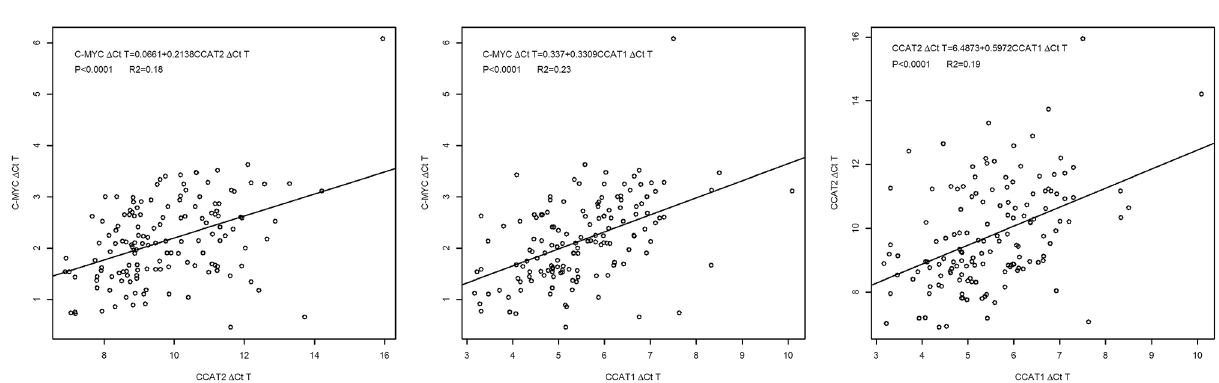
Figure 4. Linear regressions between c-Myc , CCAT1 , and CCAT2 .